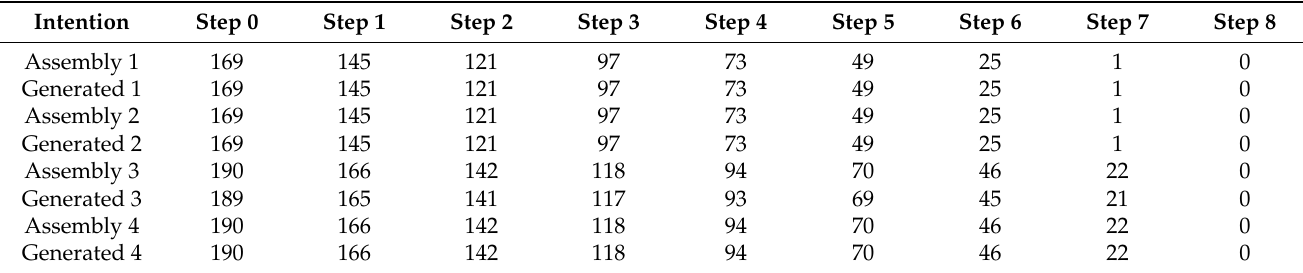
Table 8. Belief Update